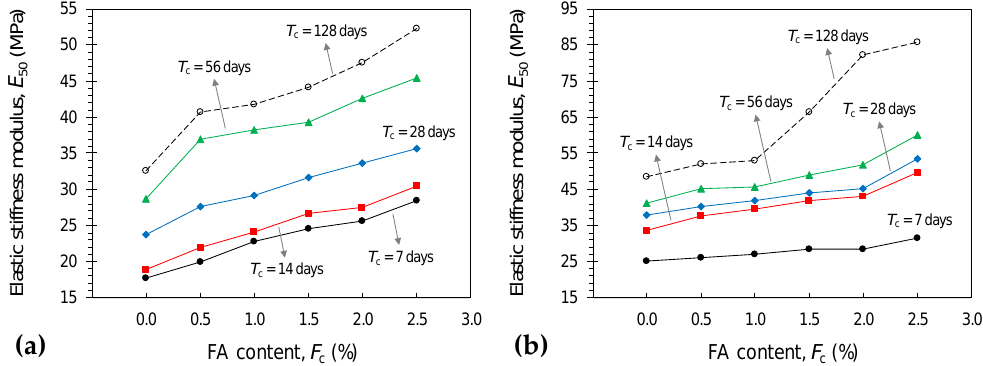
Figure 8. Variations of elastic stiffness modulus E 50 against FA content for the samples tested at various curing times: ( a ) M 1.5 F y T z ; ( b ) M 2.5 F y T z ( y = {0, 0.5, 1.0, 1.5, 2.0, 2.5} and z = {7, 14, 28, 56,